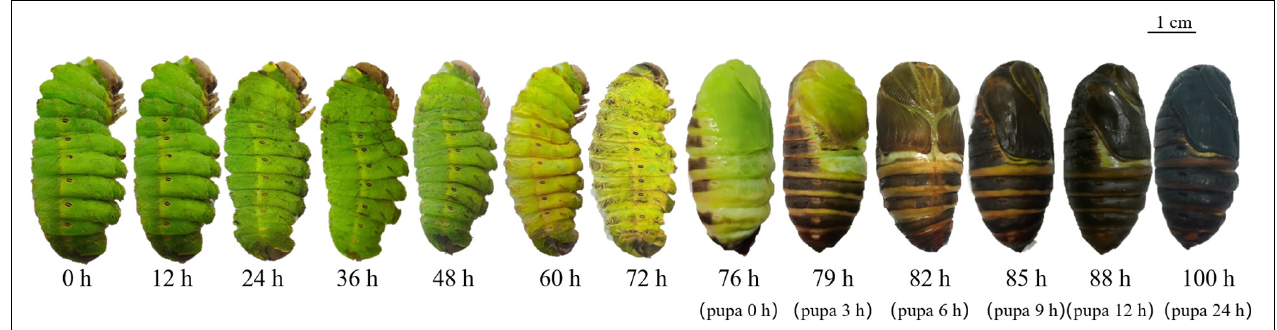
FIGURE 1 | Morphological changes from the larval to pupal stages. Changes 3 days before and 1 day after pupal emergence were recorded. Three days before pupal emergence was considered 0 h and 76 h was the beginning of pupal emergence.